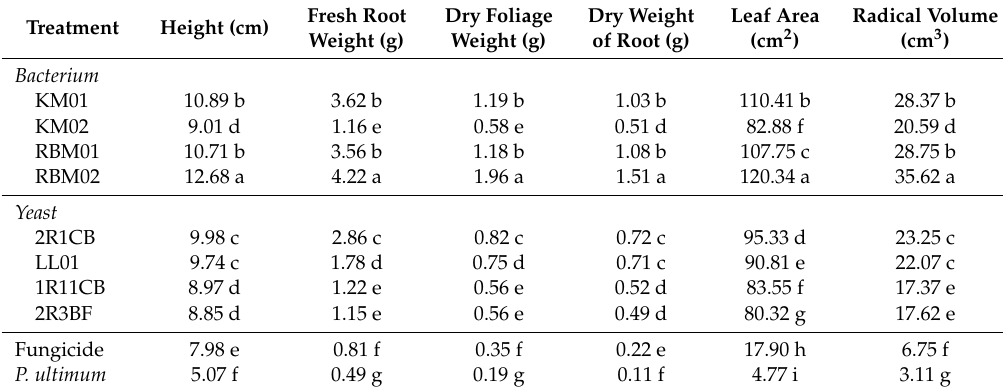
Table 2. Growth variables in the ancho-type pepper plants inoculated with marine microorganisms and Pythium ultimum .